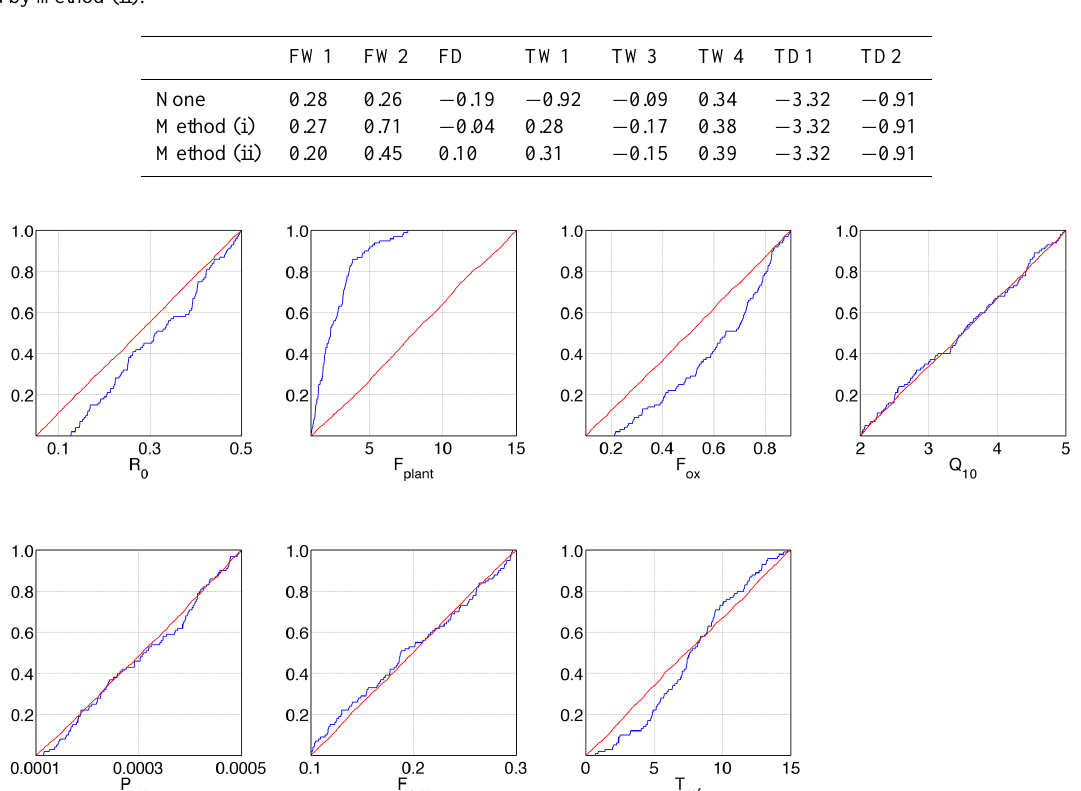
Figure 8. Deviations of cumulative distributions of parameters in CH 4 module (TW1), GPP function off. Blue: top 100 model performance. Red: all 3000 model runs. R 0 , CH 4 production rate factor; F plant , CH 4 plant transport rate factor; F ox , CH 4 plant oxidation factor; Q 10 , CH 4 production Q 10 factor; P max , maximum primary productivity; F exu , plant root exudate factor; and T ref , reference temperature for